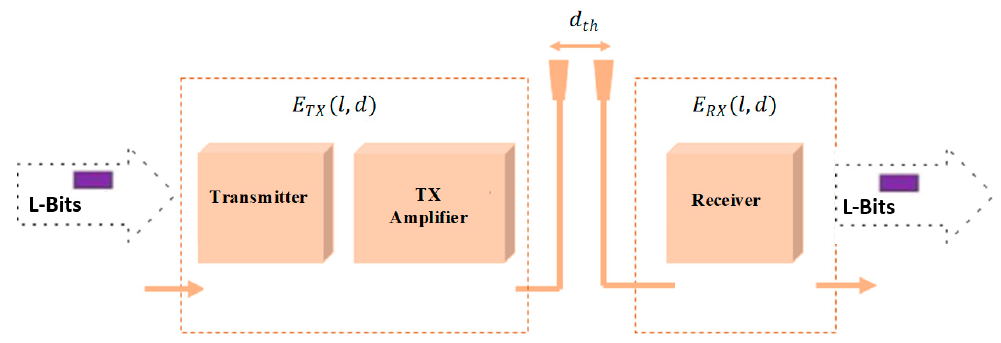
Figure 8 . Energy consumption model. Figure 8. Energy consumption